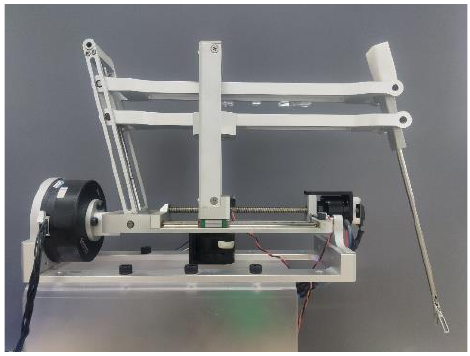
Figure 7. Prototype.